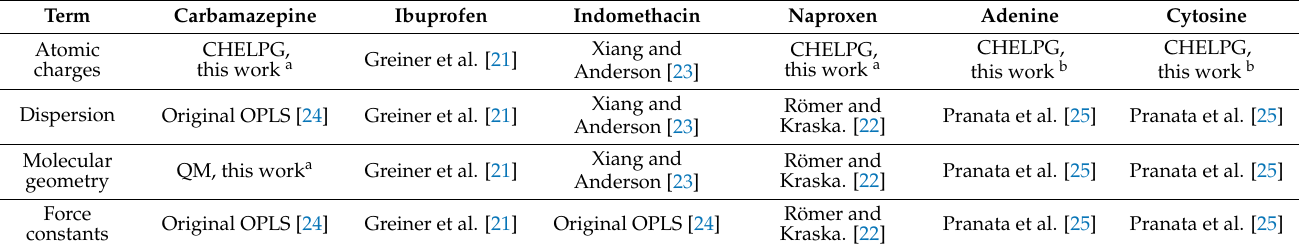
Table 1. Overview of references to the original parametrizations of force fields for individual ions included in this work.